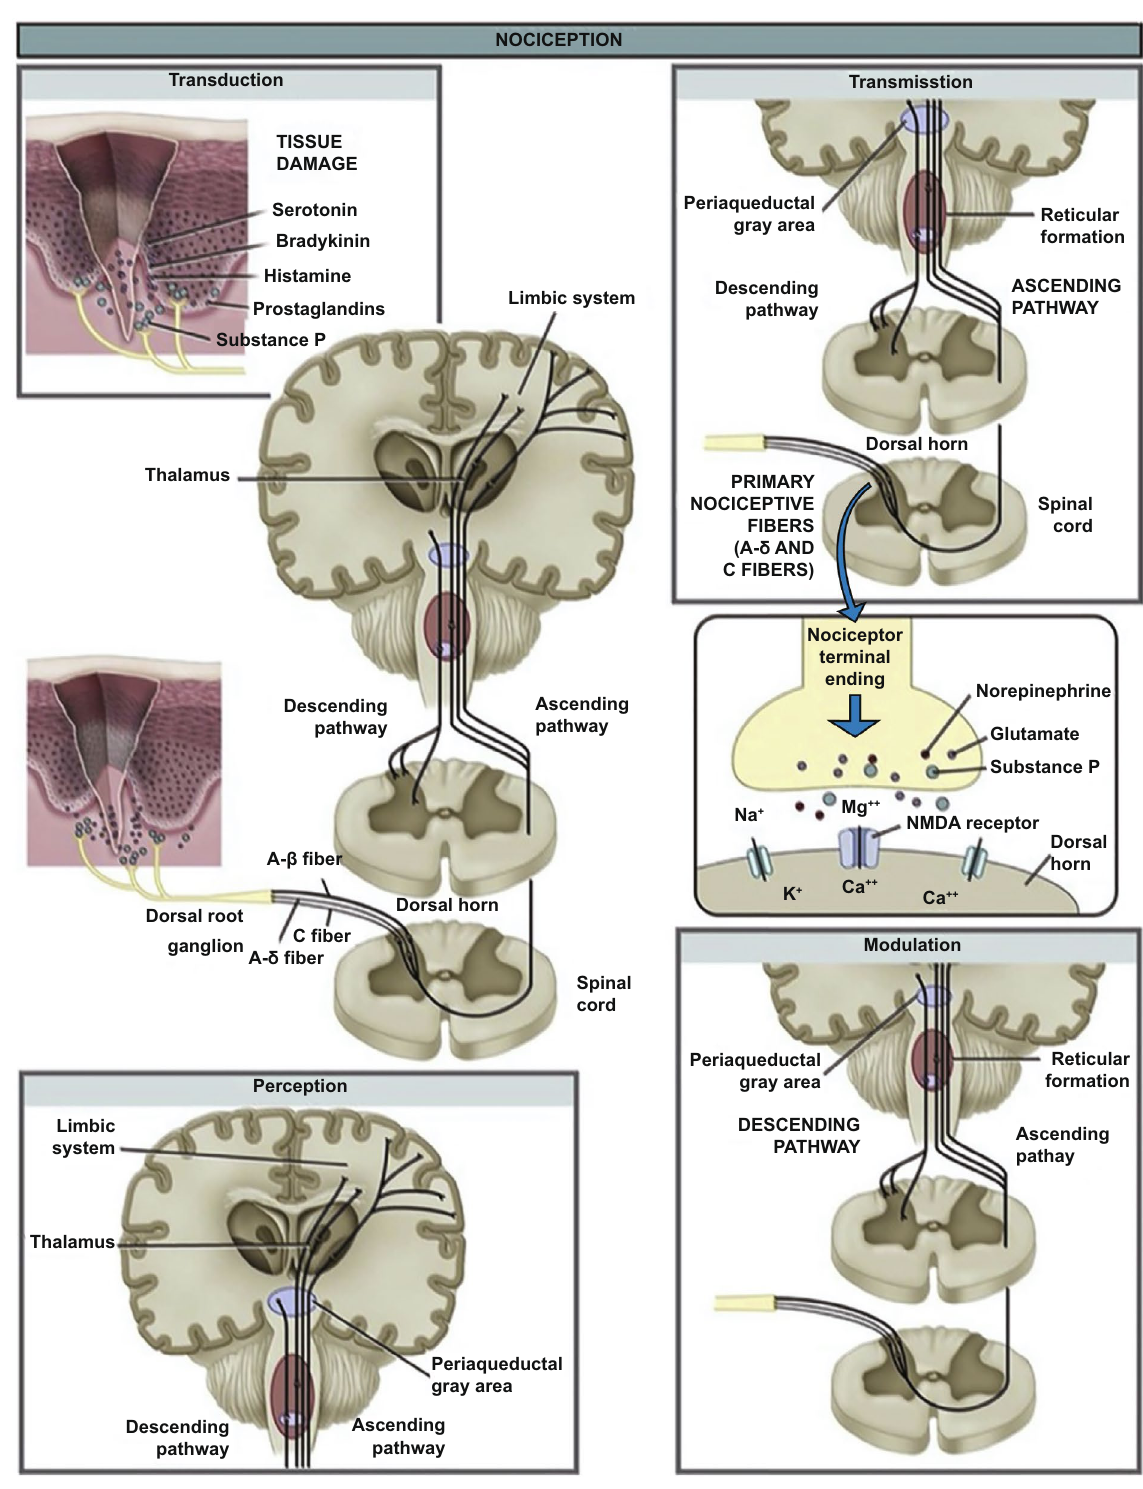
Fig. 1 The basic route of pain transmission upon noxious stimuli. There are the four phases (transduction, transmission, perception, and modu- lation) in the nociception of pain. Reprinted from Ref. [30] with permission from